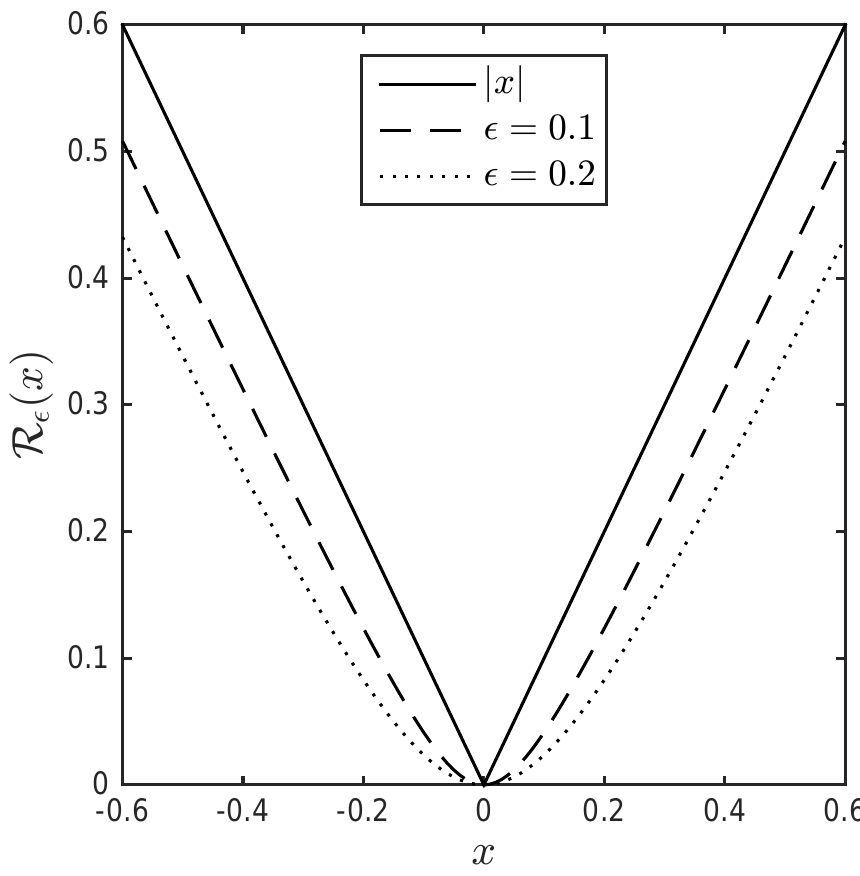
Figure 2. (cid:96) 1 / (cid:96) 2 -norm R (cid:101) ( x ) for different (cid:101)